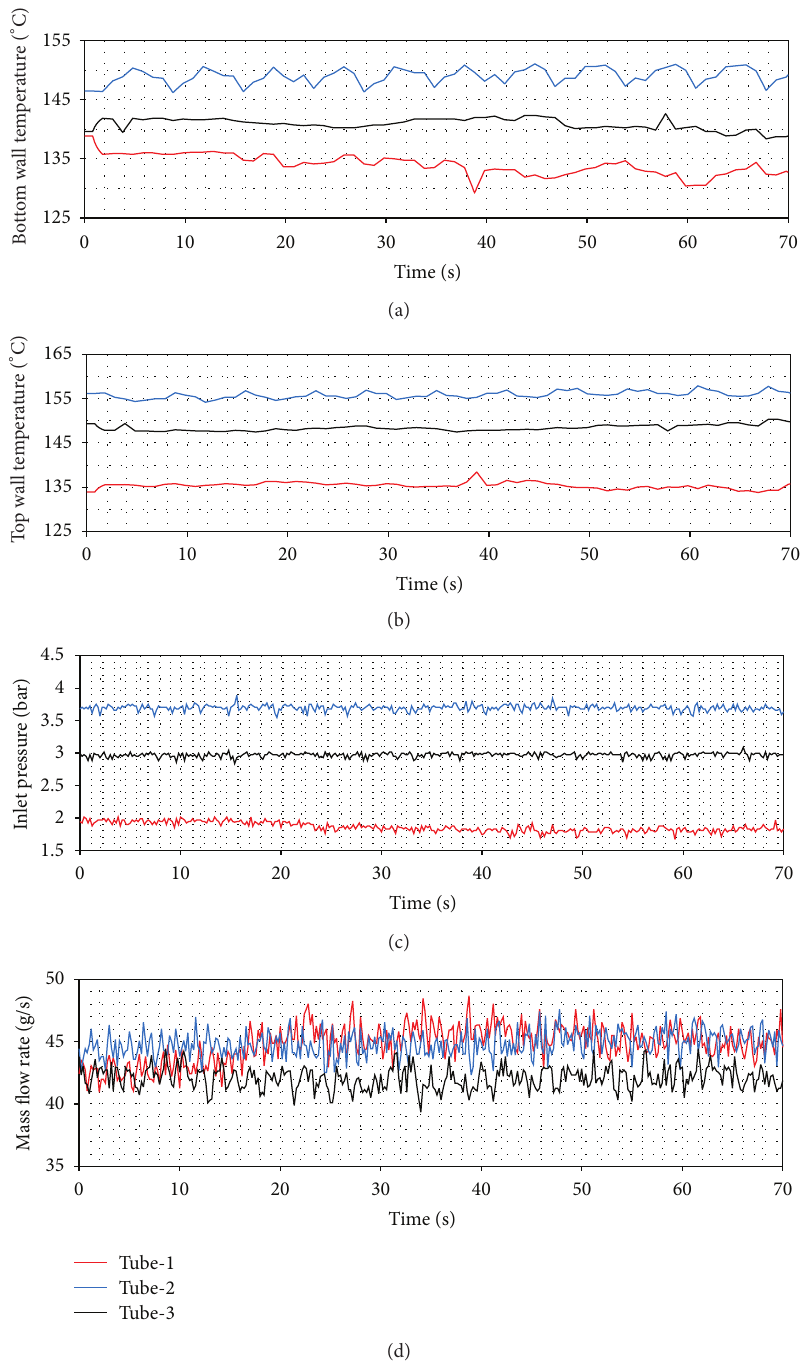
F 9: Pressure drop